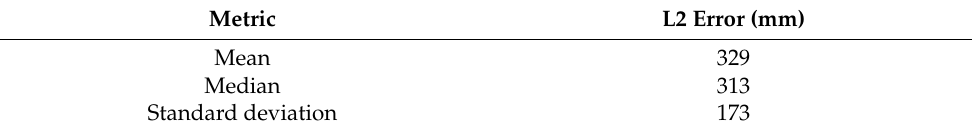
Table 6. L2 error metrics in 3D video system.